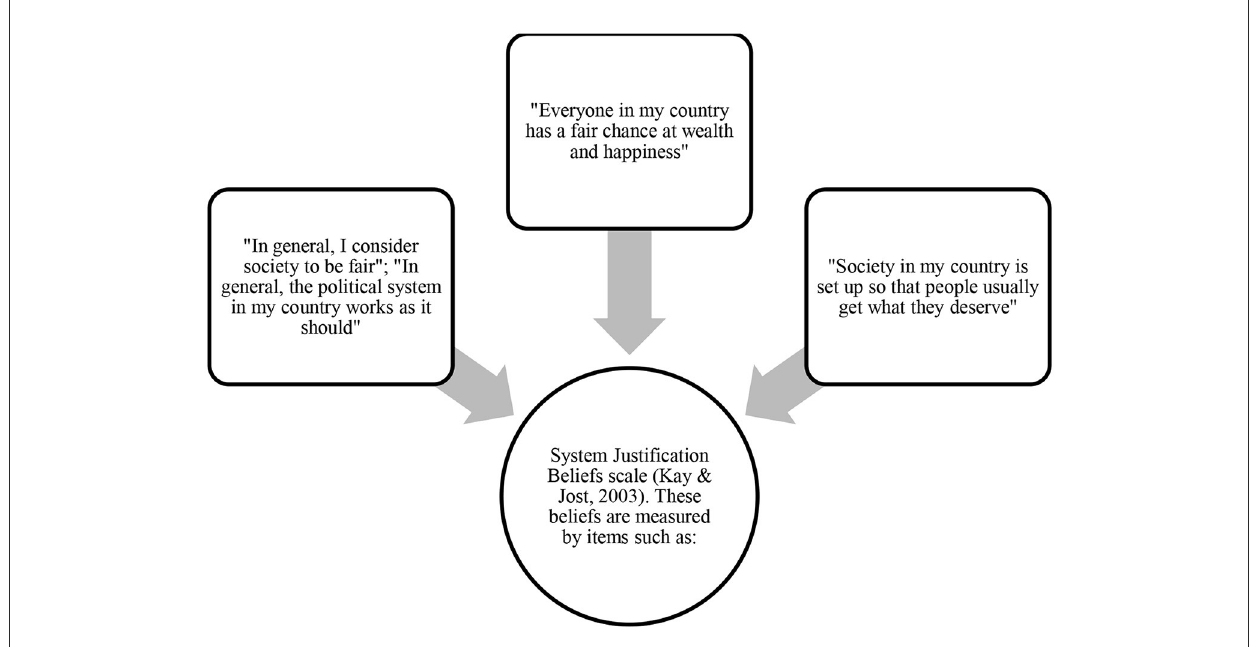
FIGURE8 Measures of “false consciousness” ideology.